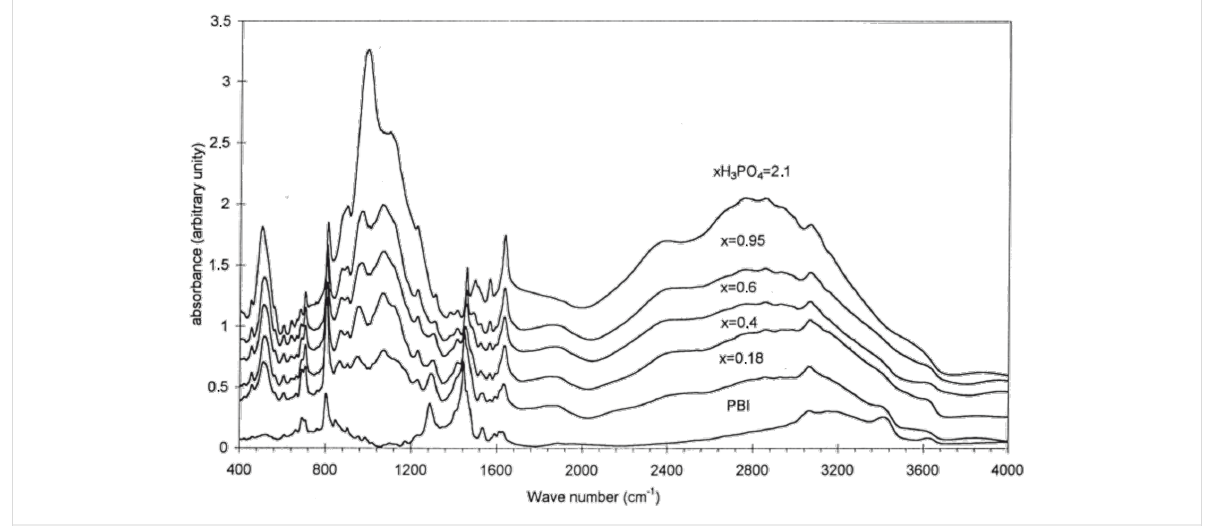
Figure 11: IR spectra of pristine and phosphoric-acid-doped PBI. Reprinted with permission from [29]. Copyright 1999 Elsevier.